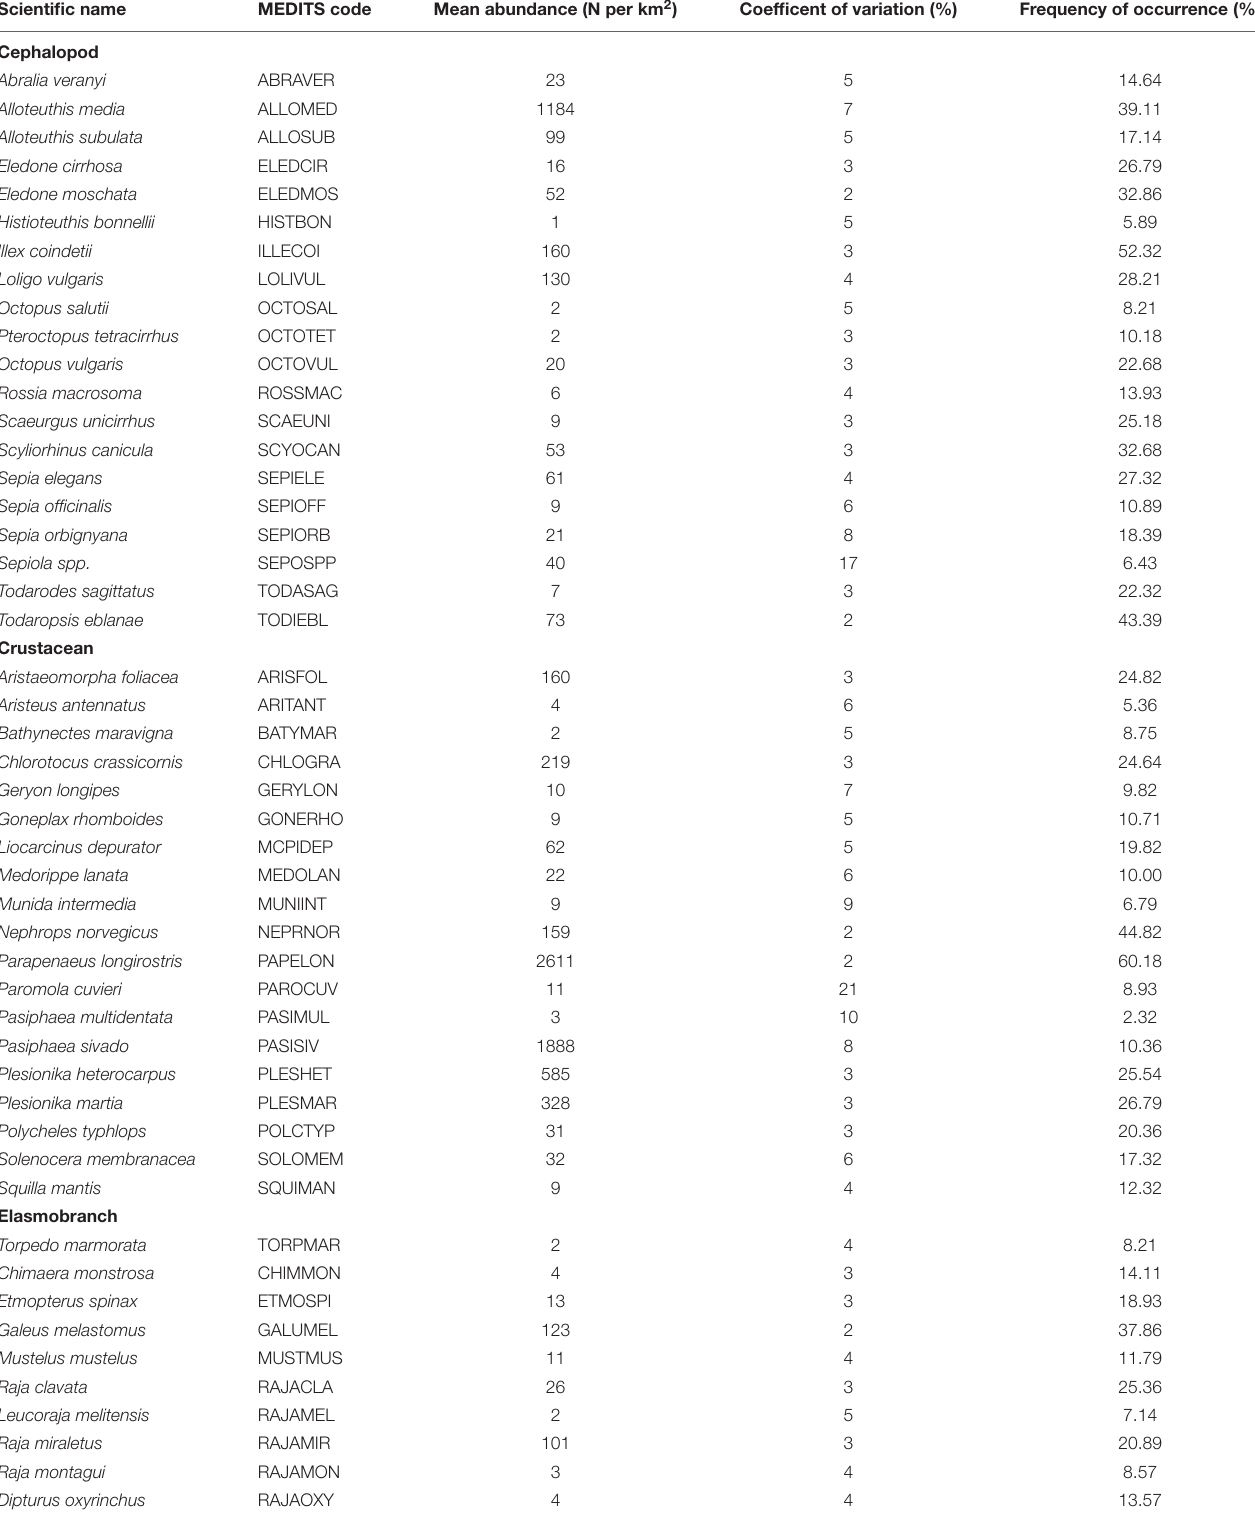
TABLE 1 | Species list of the studied community including average species abundance, coefficient of variation and frequency of occurrence (as % of total number of observation n = 560) for the period